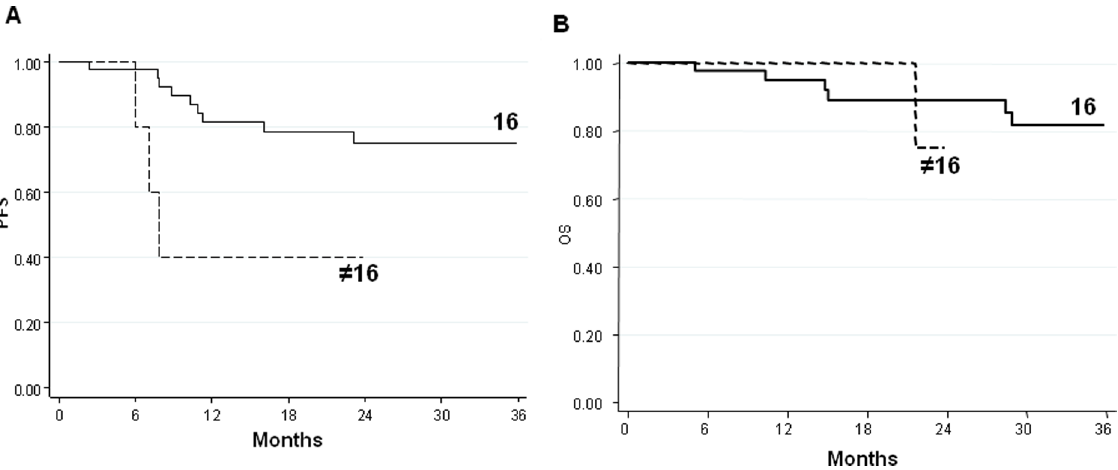
Figure 2. Kaplan-Meier survival curves of (A) progression-free survival (PFS) and (B) overall survival (OS) in relation to HPV-16 status.